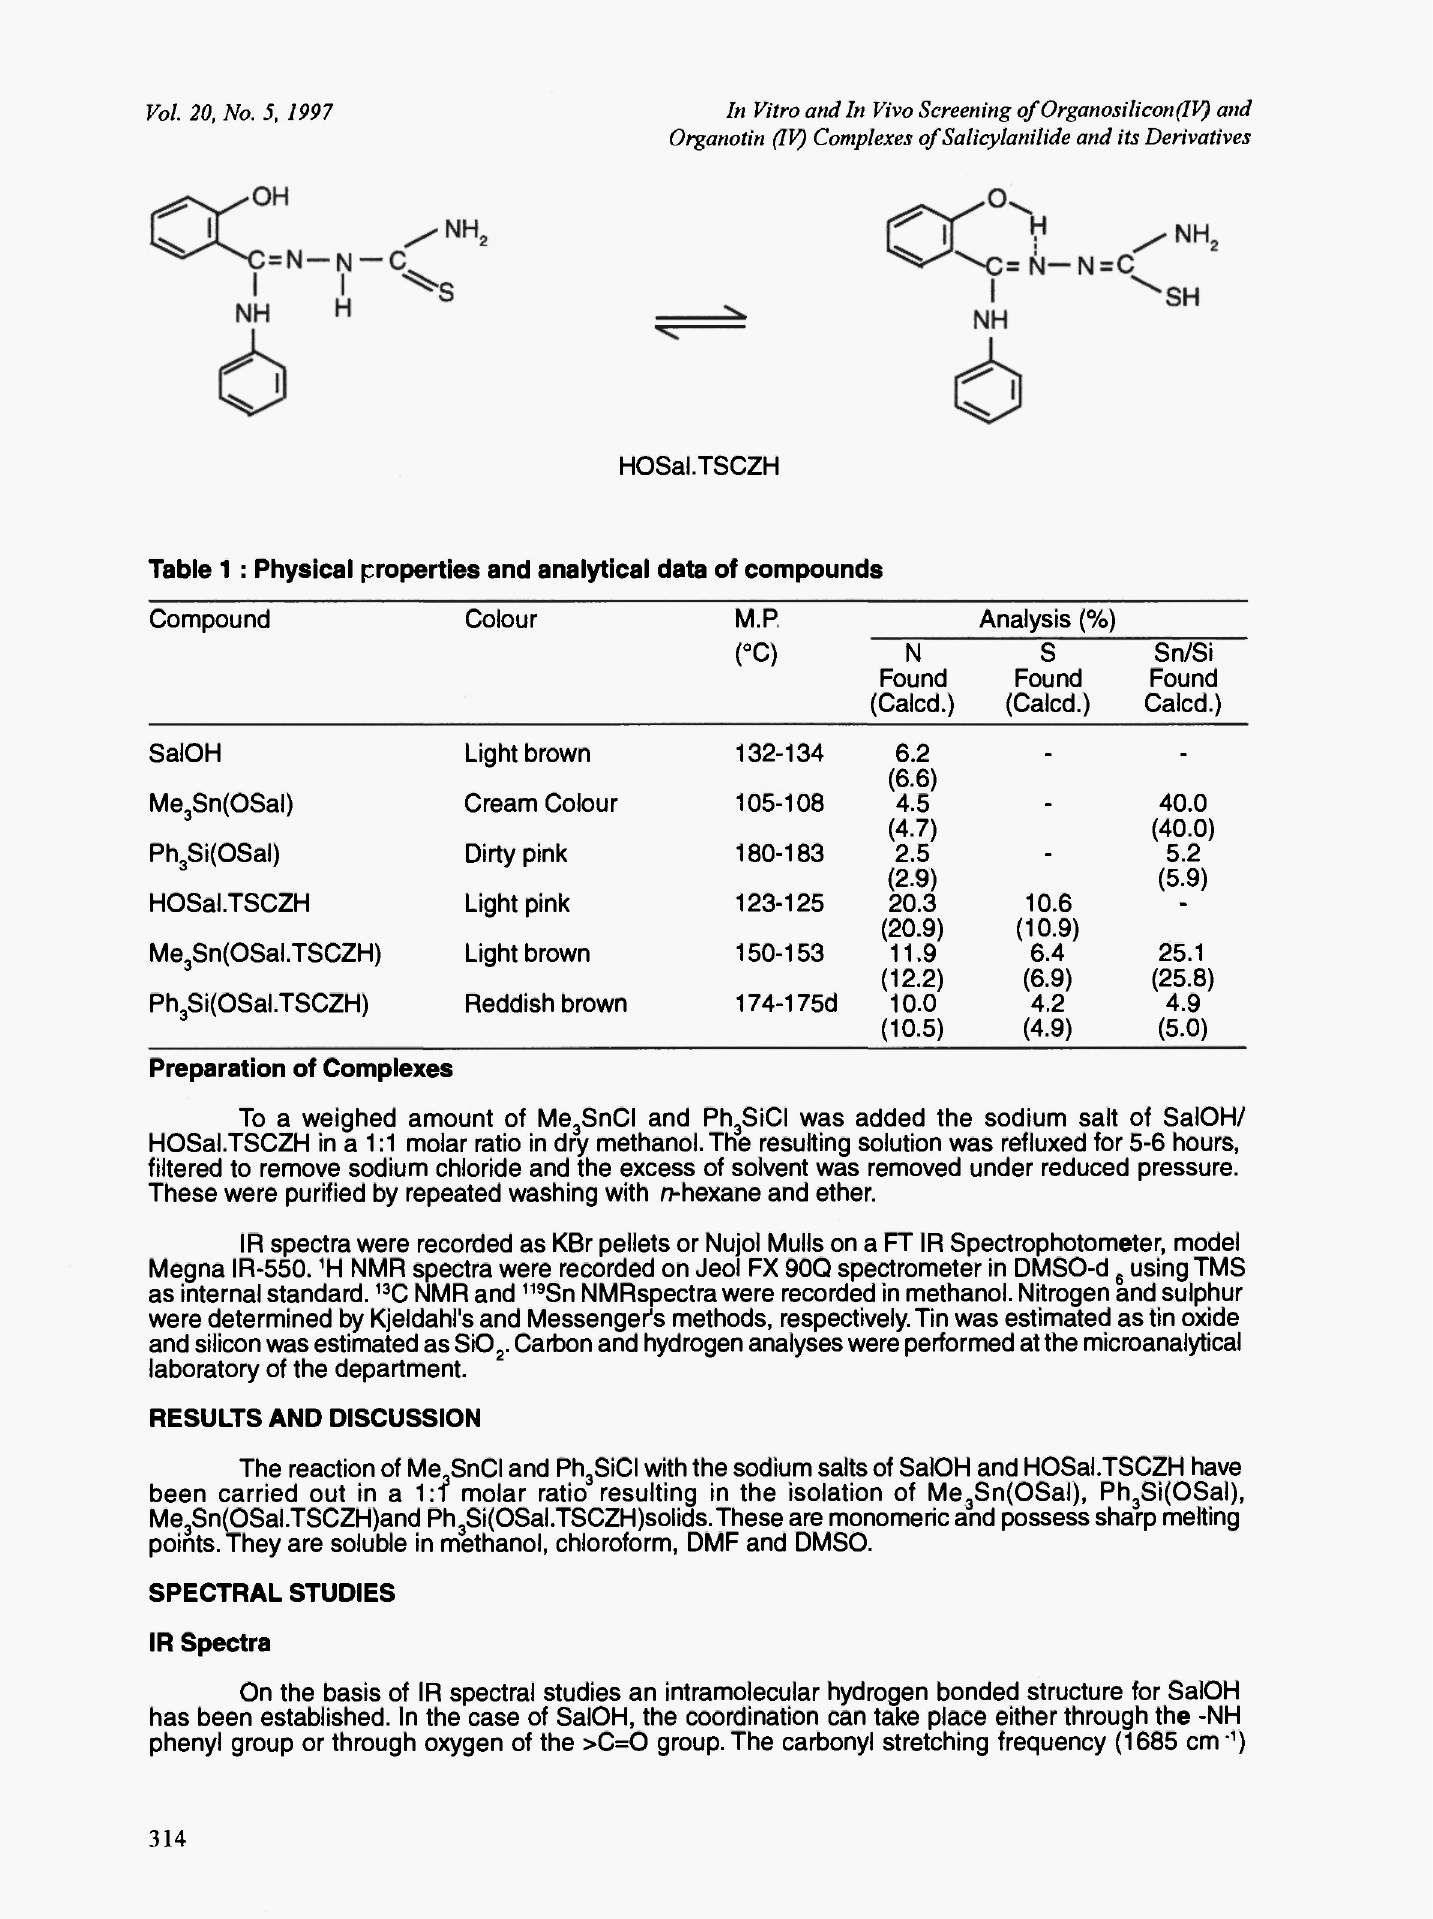
Table 1 : Physical properties and analytical data of compounds Compound Colour M.P.